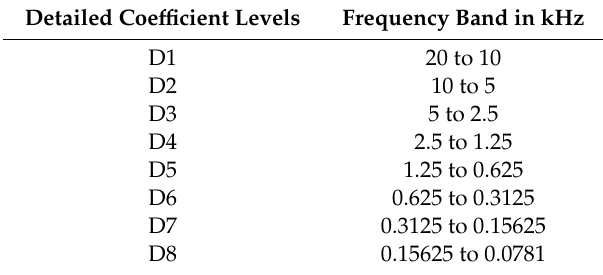
Table 1. Detailed Coe ffi cient Levels Frequency Band